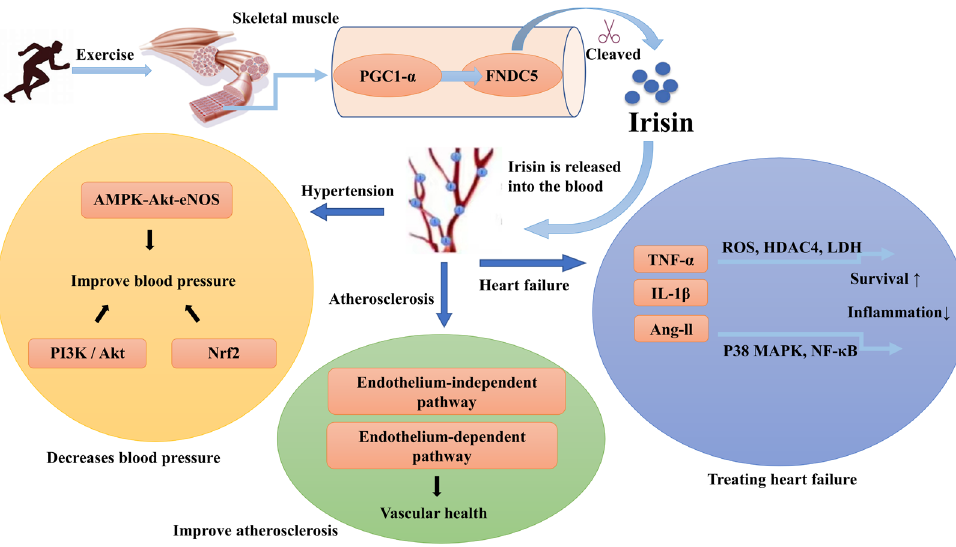
Figure 1. The mechanisms of irisin release on cardiovascular disease after exercise. Irisin, mainly secreted by muscle, may have effects on multiple organs and tissues; ROS—reactive oxygen species; P38 MAPK—p38 mitogen-activated protein kinase; PGC1- α —peroxisome proliferator-activated